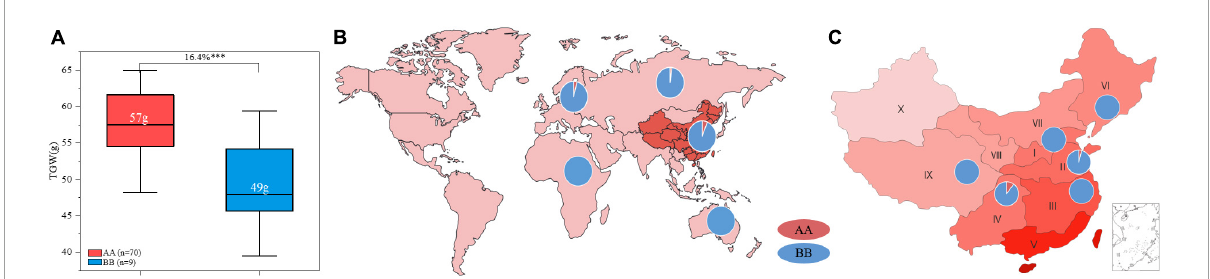
FIGURE5 Transmissibility and geographic patterns of the genotype of QTgw.cib-6A . ( A ) Contributions of QTgw.cib-6A to TGW enhancement in 79 ZKM138-derivatives. Numbers in white represent the mean value of TGW; ∗∗∗ represents significance at P < 0.001. Geographic distributions of the superior allele of QTgw.cib-6A in 624 worldwide samples (B) and 433 Chinese varieties (C) . I, Northern Winter Wheat Zone; II, Yellow and Huai River Valleys Facultative Wheat Zone; III, Middle and Lower Yangtze Valleys Autumn-Sown Spring Wheat Zone; IV, Southwestern Autumn-Sown Spring Wheat Zone; V, Southern Autumn-Sown Spring Wheat Zone; VI, Northeastern Spring Wheat Zone; VII, Northern Spring Wheat Zone; VIII, Northwestern Spring Wheat Zone; IX, Qinghai-Tibetan Plateau Spring-Winter Wheat Zone; X, Xinjiang Winter-Spring Wheat Zone; AA and BB represent varieties with and without the superior allele of QTgw.cib-6A ,